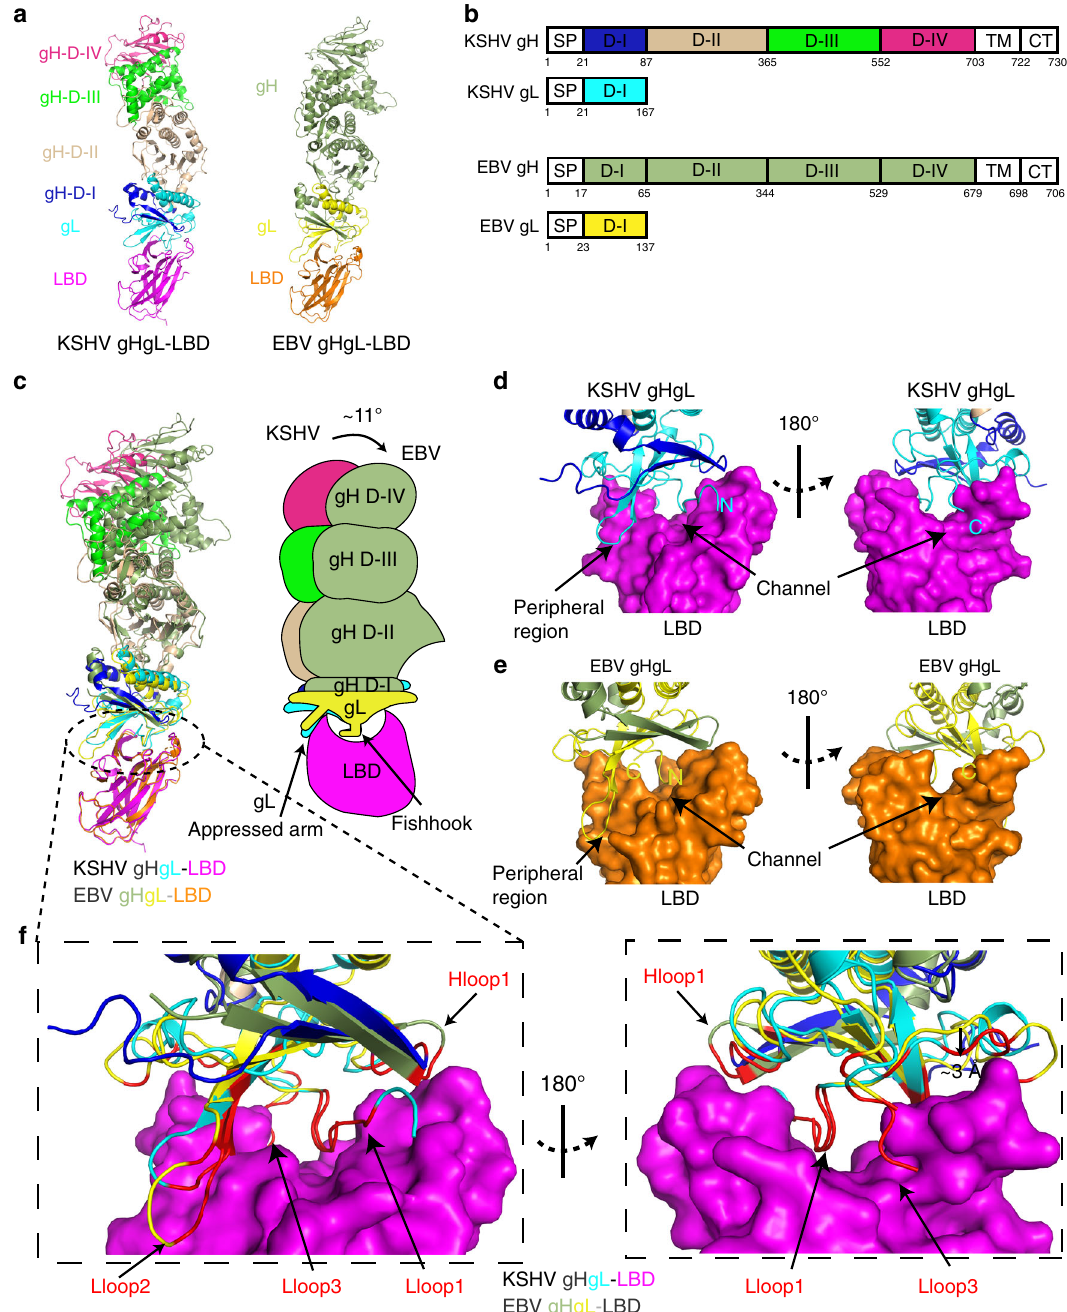
Fig. 2 The overall structures of KSHV gHgL – LBD and EBV gHgL – LBD. a Cartoon structural representations of KSHV gHgL – LBD and EBV gHgL – LBD. KSHV gH is colored blue in D-I, wheat in D-II, green in D-III, and hotpink in D-IV. EBV gH is colored smudge. KSHV and EBV gL proteins are colored cyan and yellow, respectively. The LBDs of KSHV gHgL – LBD and EBV gHgL – LBD are colored magenta and orange, respectively. b Schematic representation of the KSHV gHgL and EBV gHgL. CT: C-terminal cytoplasmic tail domain, SP: signal peptide, TM: transmembrane. Different colored regions of KSHV gHgL correspond to the different structural domains shown in Fig. 2a. c Superimposition of KSHV gHgL – LBD and EBV gHgL – LBD. KSHV gHgL – LBD and EBV gHgL – LBD are colored as in Fig. 2a. Cartoon diagrams and binding mode pattern are shown. The shift angle and two binding regions of gL to LBD are shown. gL binds to LBD like a fi shhook and appressed arm. d , e Binding mode of KSHV gHgL ( d ) and EBV gHgL ( e ) to LBD. The surface of LBD is shown, and the channel and peripheral regions of LBD are labeled. The N and C termini of gL are labeled N and C, respectively. f Comparison of the LBD-binding interfaces between KSHV gHgL and EBV gHgL. KSHV gHgL – LBD and EBV gHgL – LBD are colored as in Fig. 2a. The surface of LBD is shown. The LBD- binding residues of KSHV gHgL and EBV gHgL are colored red. The Hloop1, Lloop1 – 3, and β 2 regions of KSHV gHgL are